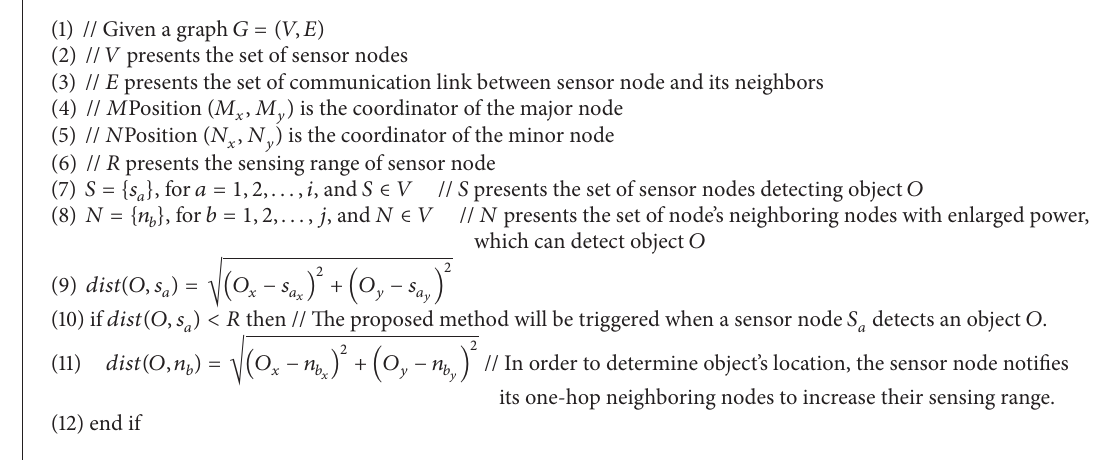
Algorithm 1: Algorithm with distance formula for the proposed location estimation.